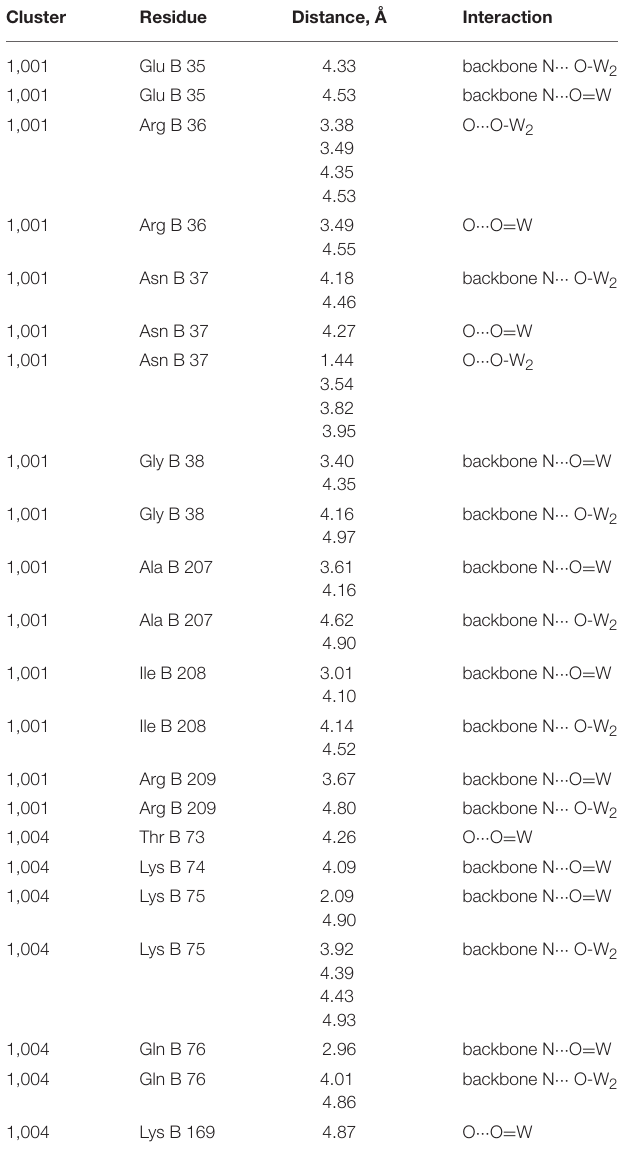
TABLE 1 | Interactions between Wells-Dawson Clusters 1,001 and 1,004 with protein moieties (Pioletti et al., 2001).